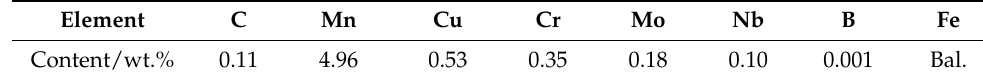
Table 1. Chemical composition of the test steel.